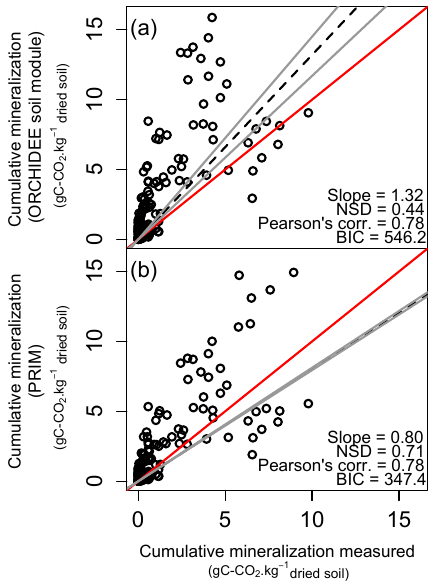
Figure 3. Scatter plot between independent data from optimiza- tion (data set describes in Sect. 2.2.2) and the soil module of OR- CHIDEE outputs (a) or between data and the PRIM model out- puts (b) . Red lines indicate the 1:1 line.